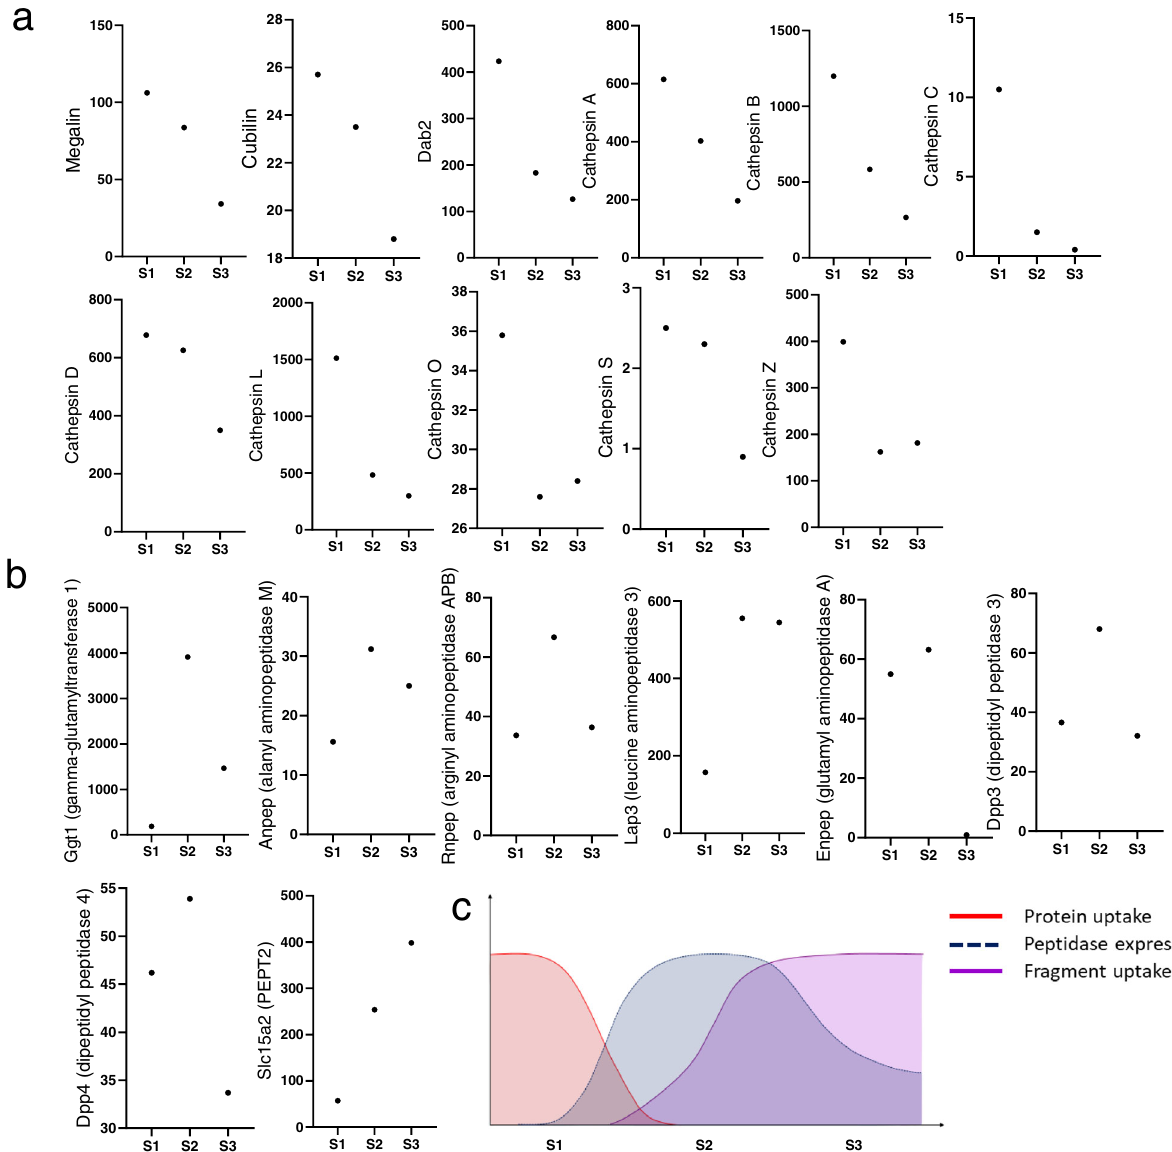
Fig. 3 | Expression of genes related to protein and peptide handling along the mouse proximal tubule. a The multi-ligand receptors megalin and cubilin, the endocytotic adaptor protein Dab2,and protein degrading cathepsins areall highly expressed in S1. b In contrast, peptidases are more abundant in S2, and the expression of the major renal peptide transporter (PEPT2) increases progressively